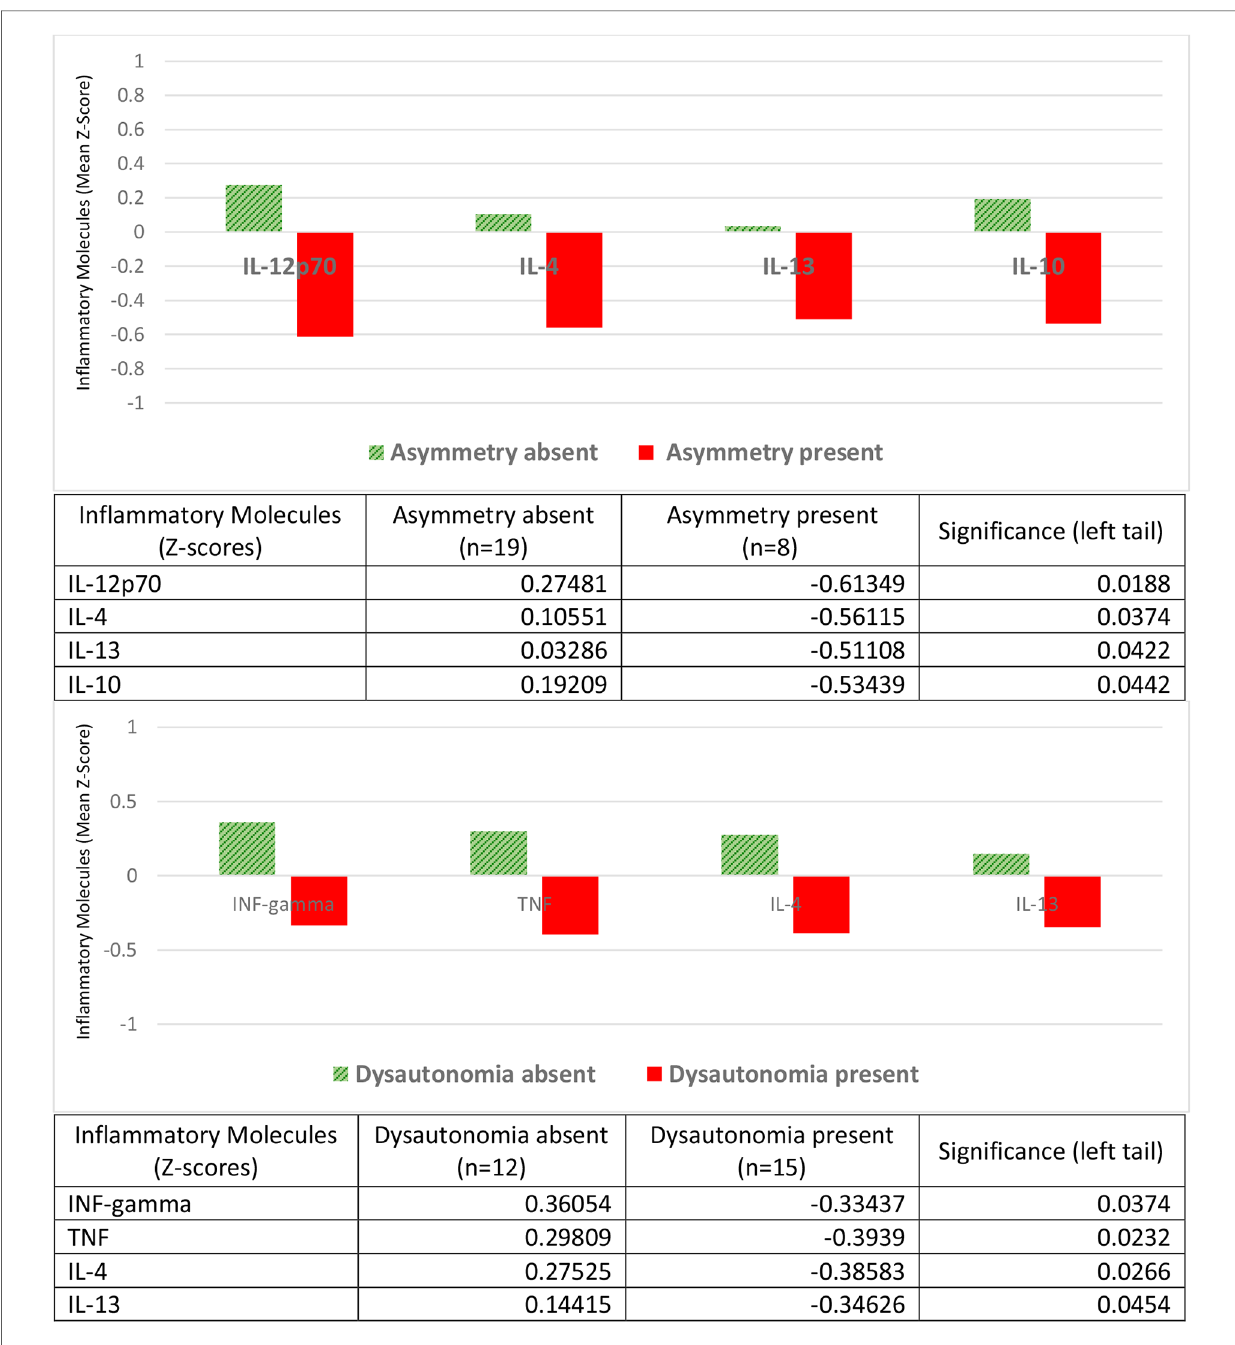
FIGURE 3 In fl ammatory molecules and neurological disorders: asymmetry and dysautonomia. Children with neurological alterations had negative Z -scores for mean concentrations of the proin fl ammatory molecules IL-12p70 (asymmetry), or IFN-gamma and TNF (dysautonomia); they also had negative Z -scores for the anti-in fl ammatory molecules IL-4 and IL-13 (asymmetry and dysautonomia) and IL-10 (asymmetry). Children without neurological alterations had positive Z -scores for these cytokines. Tables express complete numerical data and between-group signi fi